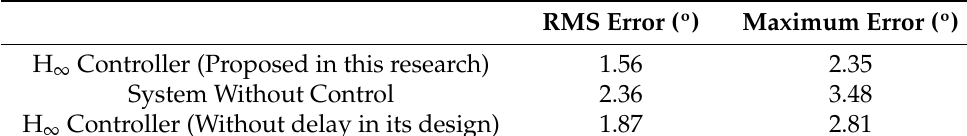
Table 4. RMS and maximum errors of the roll angle for test 2.